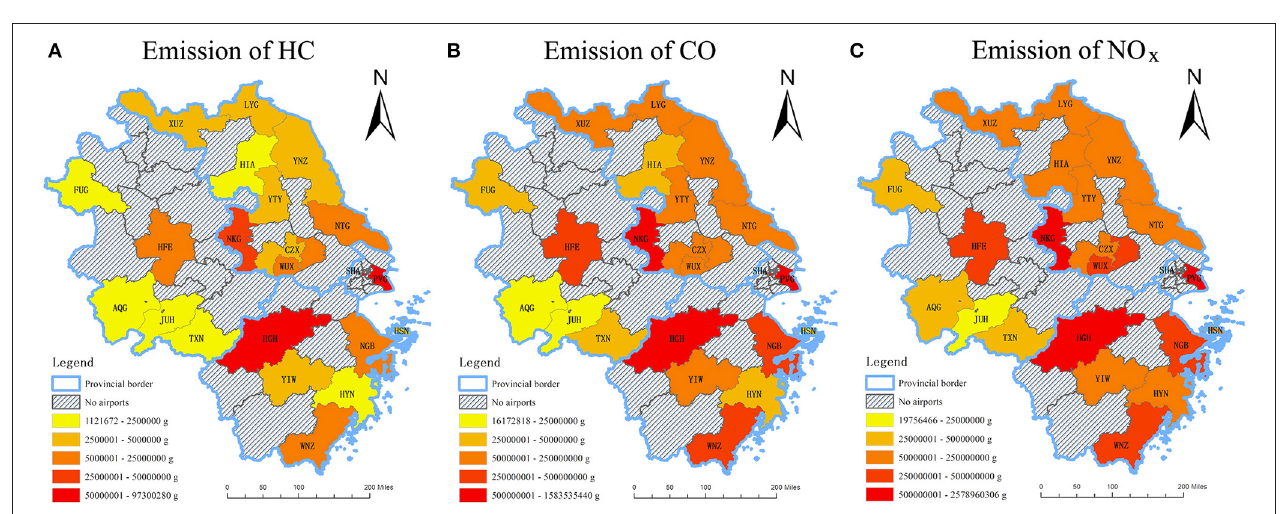
FIGURE 7 | Total emission quantities of HC, CO, and NO x in spatial scale, 2020. (A) Emission quantity of HC (B) Emission quantity of CO (C) Emission quantity of NO x .